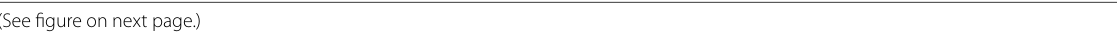
figure on next Fig. 5 Indicator species in both mastitis (MCMF and MCMMT) and healthy (HMF and HMMT) mice metagenomes. Differentially enriched indicator species in different sample groups of mouse mastitis model. Indicator values are shown next to the taxonomic information for the indicator taxa as indicated by Indicator. Only highly significant indicator values (IndVal > 0.6, p < 0.01) are displayed. Size of bubble is proportional to the mean relative abundance of each species in the corresponding sample group, and the color scale bar shows indicator value for each taxon. Red color indicate the level of significance for which group the taxon is an indicator. Grey symbols indicate group that contain a taxon, but for which that taxon is not an indicator